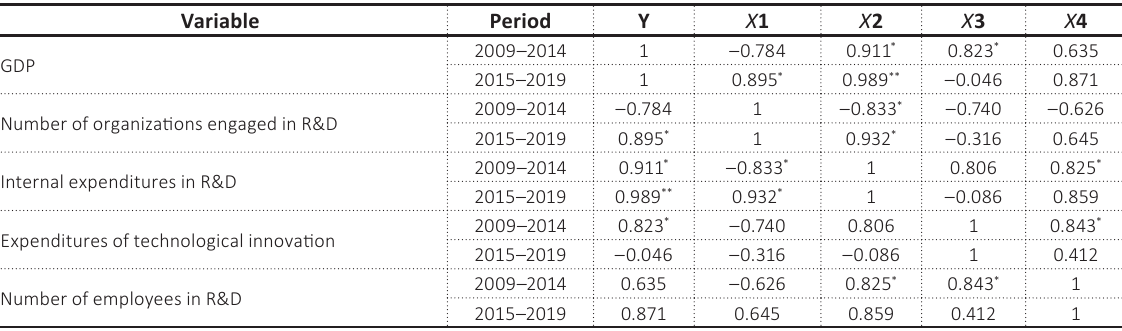
Source: Bureau of National Statistics